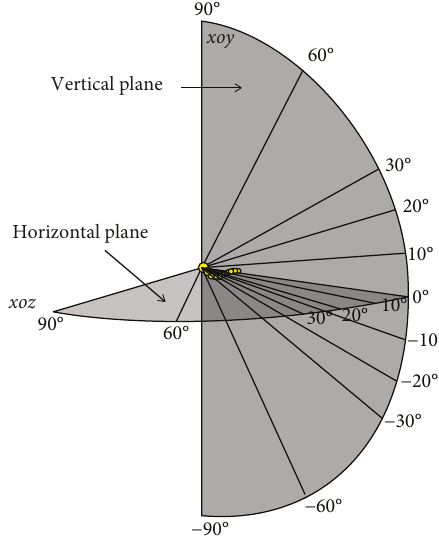
Figure 18. Except for the friction loss, vortice pairs present at